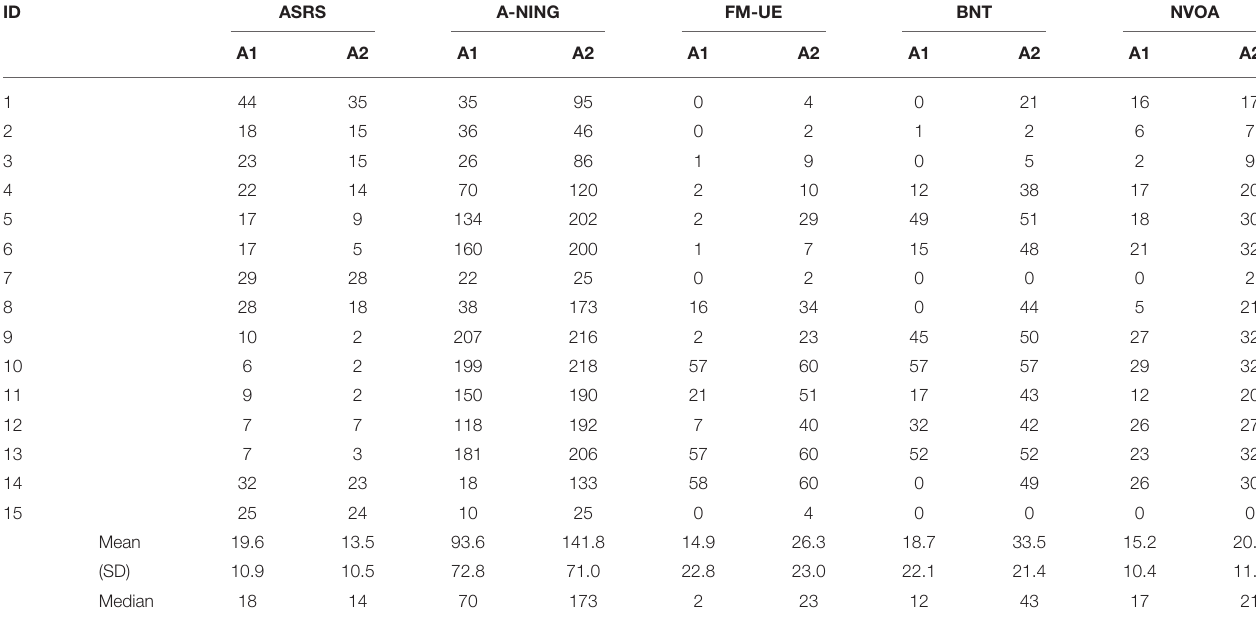
TABLE 3 | Behavioral measurements, total score results, assessment 1 (A1) and 2 (A2) ( n =